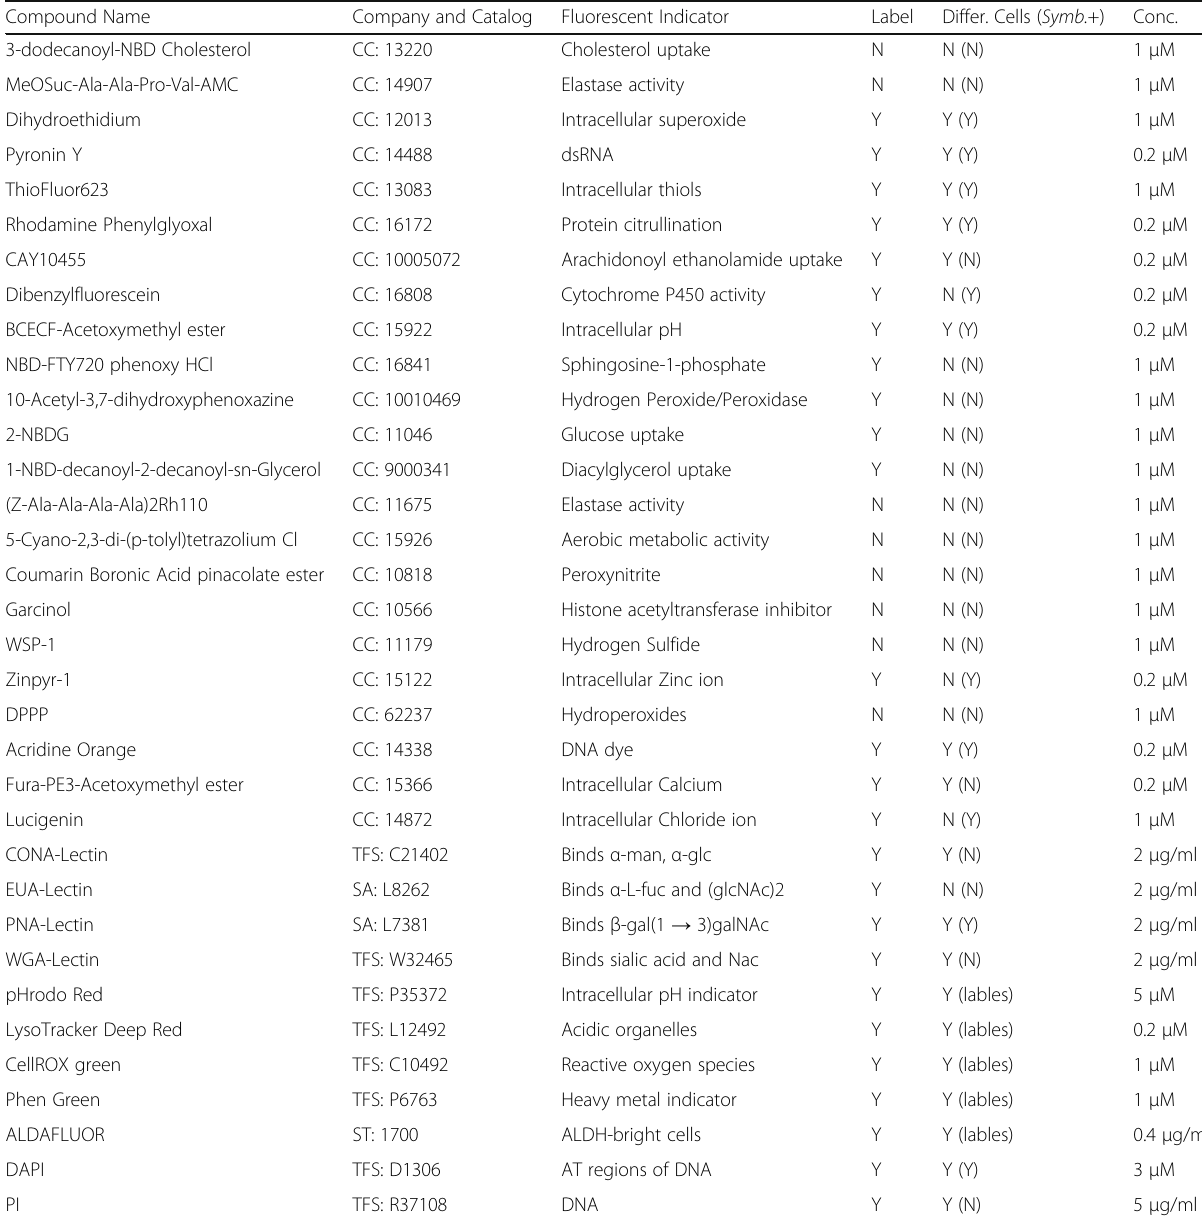
Table 1 Screened compounds to differentiate coral